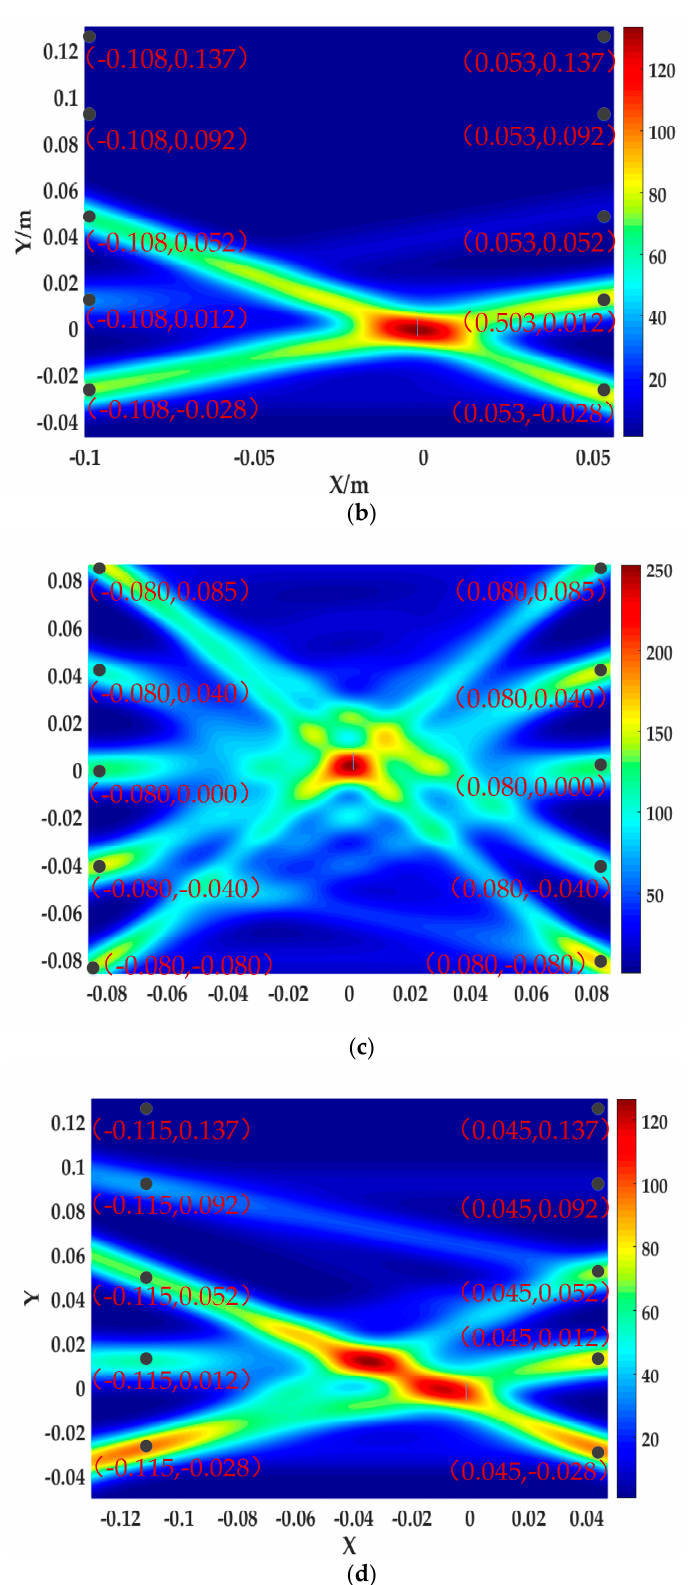
Figure 16. Positioning results in experiment: ( a ) Microcrack in the right side; ( b ) microcrack in the lower right corner; ( c ) microcrack in the middle; ( d ) no scanning center line through microcrack.